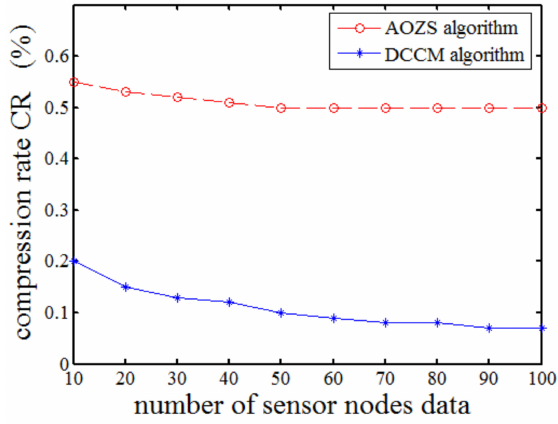
Figure 13. The Comparison of data compression ratio.